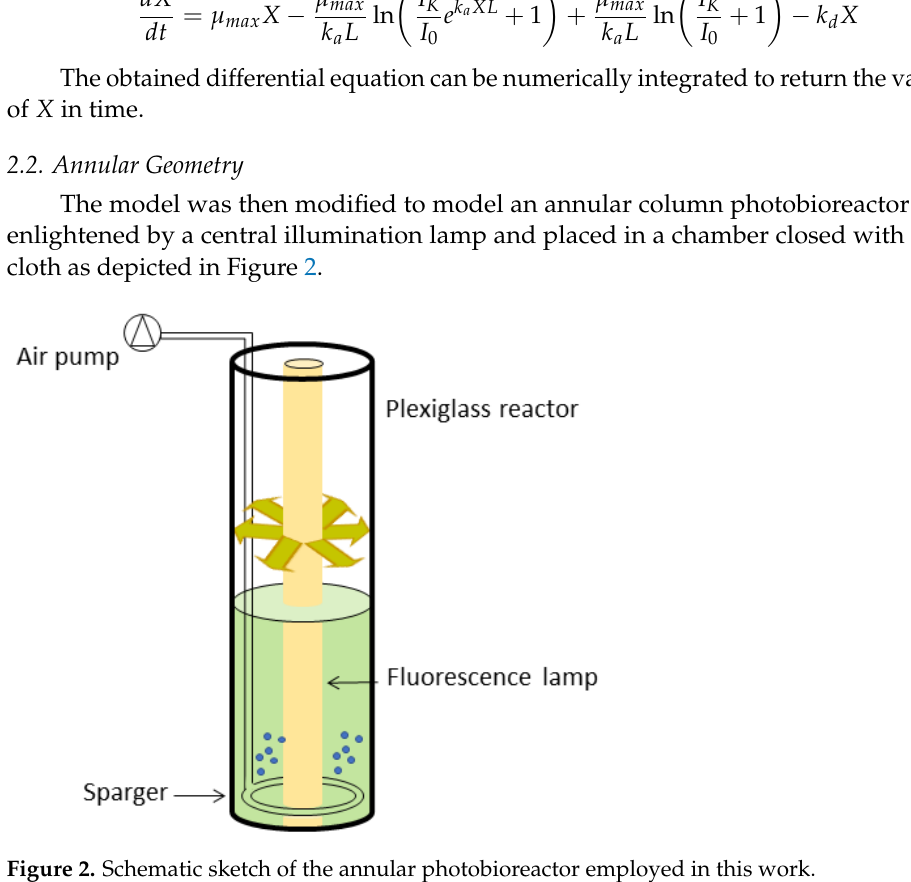
Figure 2. Schematic sketch of the annular photobioreactor employed in this